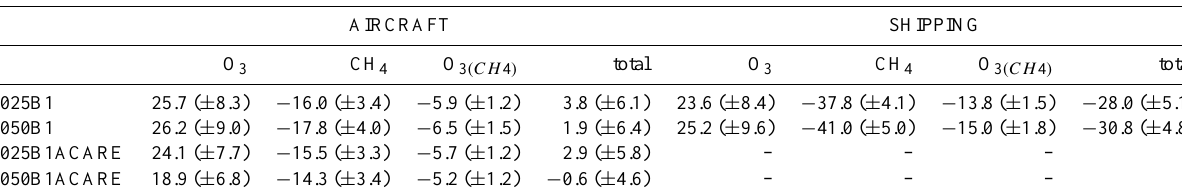
Table 5. Radiative forcings (mWm − 2 ) from changes in ozone, methane (including stratospheric water vapour), and methane-induced ozone for different transport sectors and years/scenarios given as ensemble means and standard deviations. Note that the history of emissions has been taken into account, and that the fully scaled perturbations were used.